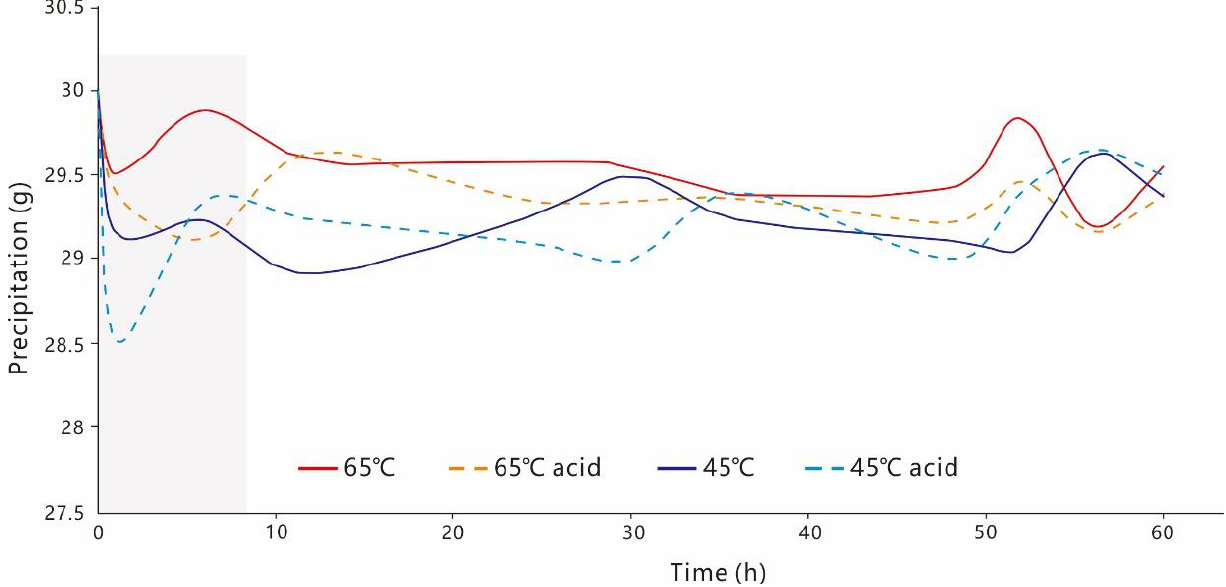
Figure 6. Residual precipitation amounts under different conditions over time. The gray square shadow represents the initial state of dissolution and precipitation under different conditions.